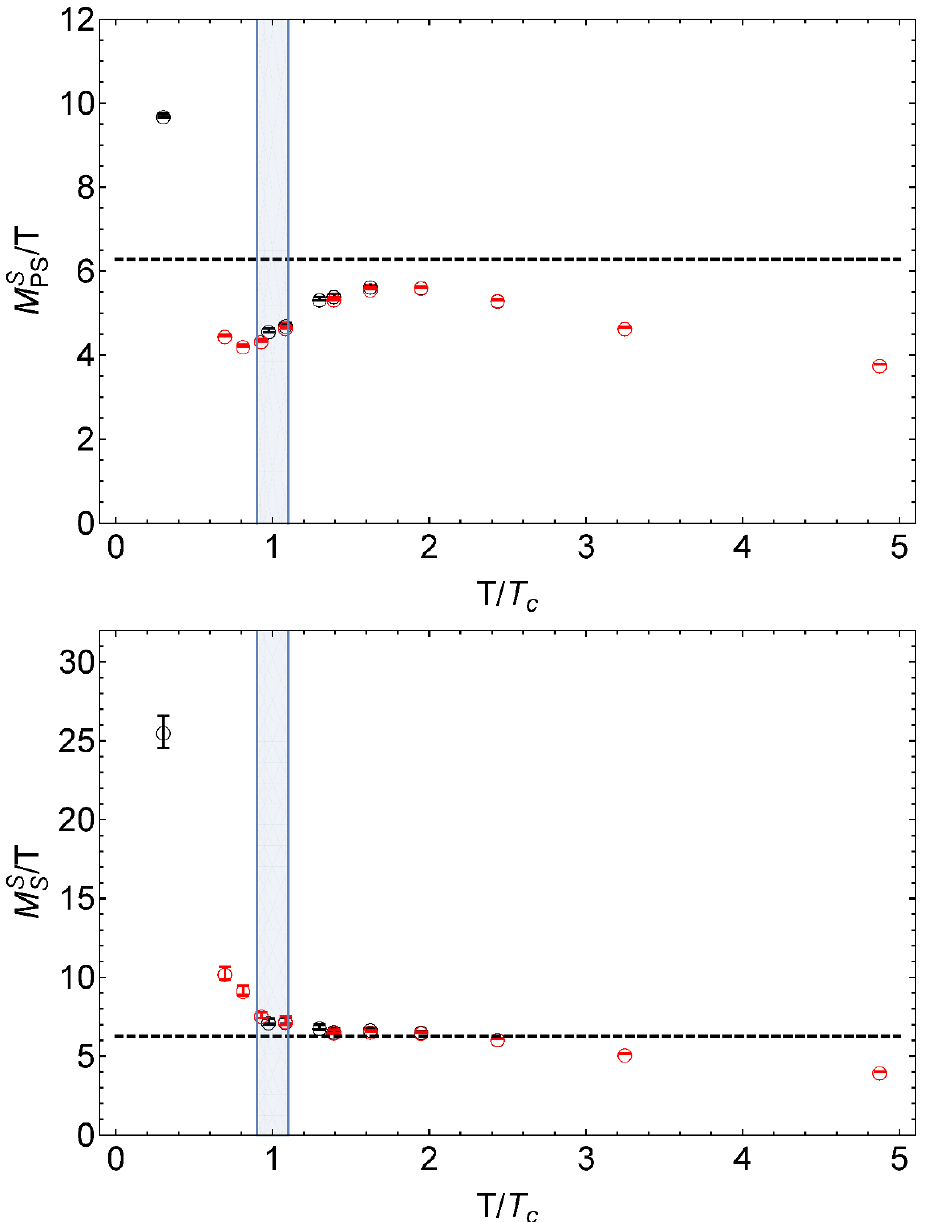
Figure 11 . Screening masses normalized by temperature for pseudoscalar (top) and scalar (bottom) mesons. Black and red points are extracted from ensembles of N t (cid:2) 16 3 and N t (cid:2) 16 2 (cid:2) 24, respectively. The temperature is in units of T c , where the blue vertical band denotes the uncertainty of T c .